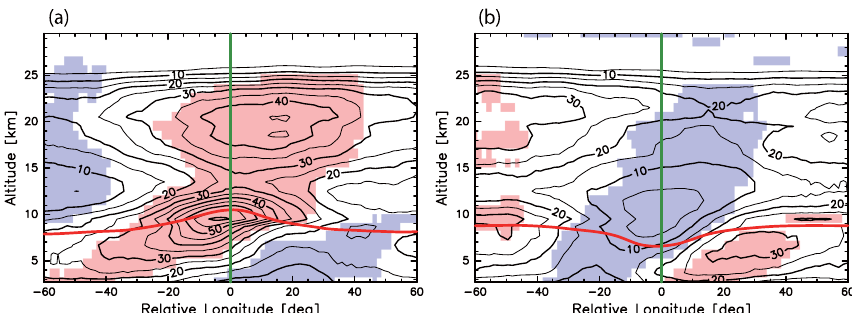
Fig. 7. (a) A composite of relative longitude and altitude of PSC/UC frequency (contours) with a reference longitude (green line) where PV anomalies from the zonal mean are positive and maximized in the zonal direction at 72.5 ◦ S on a 300K isentropic surface for each day, and with values larger than 1.5PVU. The number of cases used for the composite is 368. Contour intervals are 5%. Red-shaded (blue-shaded) areas are the regions with PSC/UC frequencies higher (lower) than their averaged values and with significance levels greater than 95%. The red thick curve indicates the composite of the blended tropopause. (b) The same as (a) but when using a reference longitude where PV anomalies from the zonal mean are negative and minimized in the zonal direction at 72.5 ◦ S on a 300K isentropic surface for each day, and with values smaller than − 1.5PVU. The number of cases used for the composite is 374. Time period for both plots is June through August from 2007 to